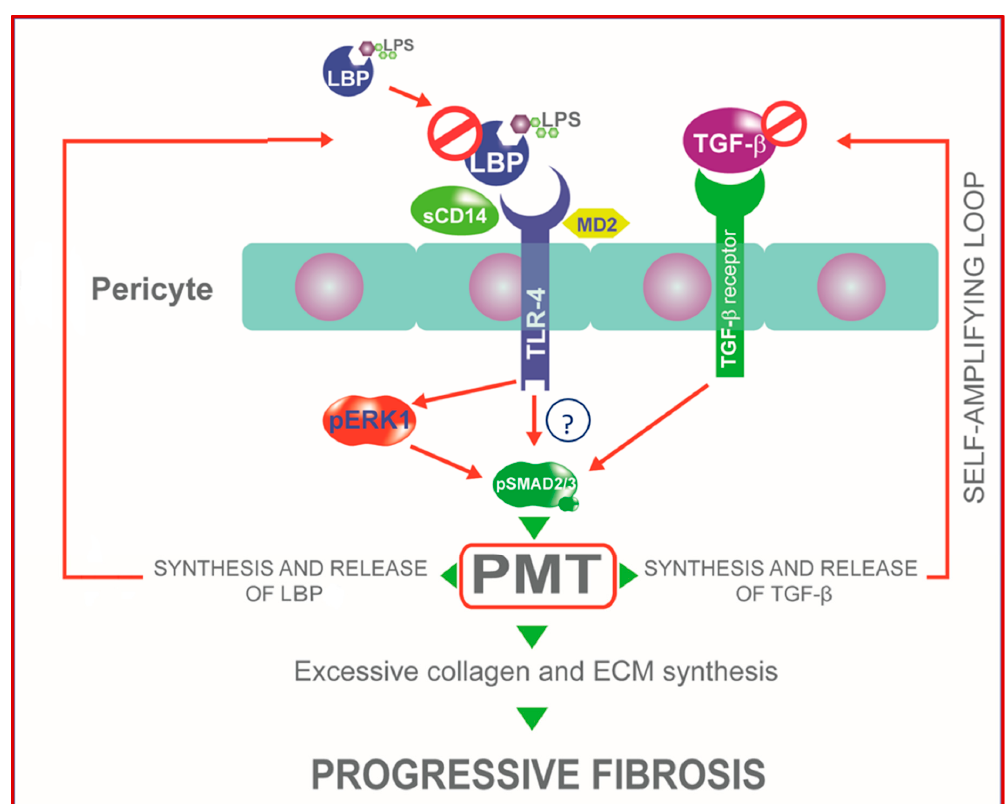
Figure A1. CPFA reduced activation of pericytes and PMT by LBP and TGF- β removal from septic sera. Pericyte TLR4 signaling might contribute to further accumulation of TGF- β and LBP, developing a self-sustaining feed-forward loop that amplifies and maintains renal fibrosis. Disrupting persistent TLR4 signaling activation by the removal of LBP and other molecules as TGF- β represents a potential novel strategy for breaking the cycle of progressive fibrosis.